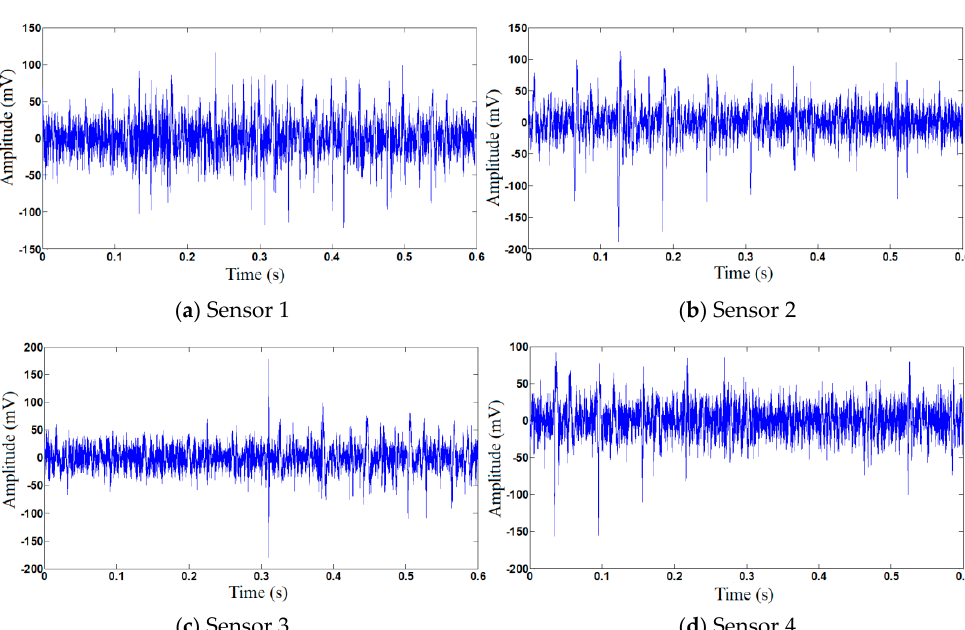
Figure 3. Sensor locations in the experiments.